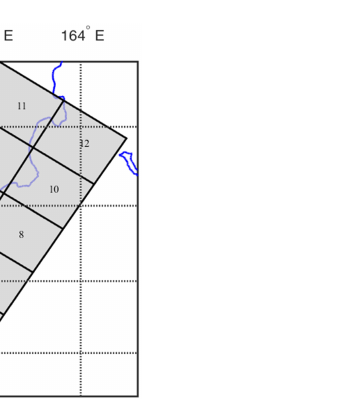
which the study of the seismic regime is equal to T = 1962 − 2021. On Fig. 2, as an example, the values of probabilities of seismic events in the region S 2 are presented.